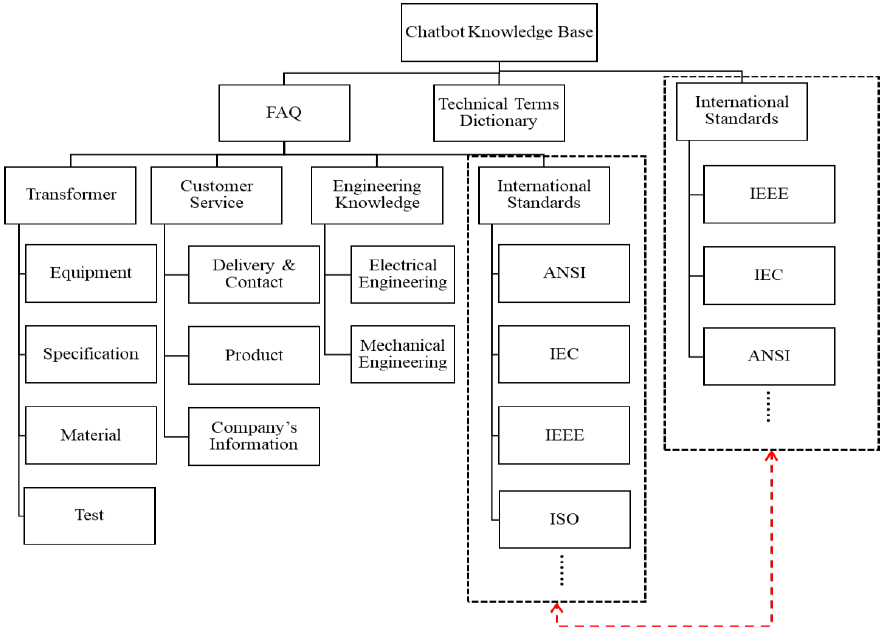
Figure 6. The chatbot knowledge base schema.